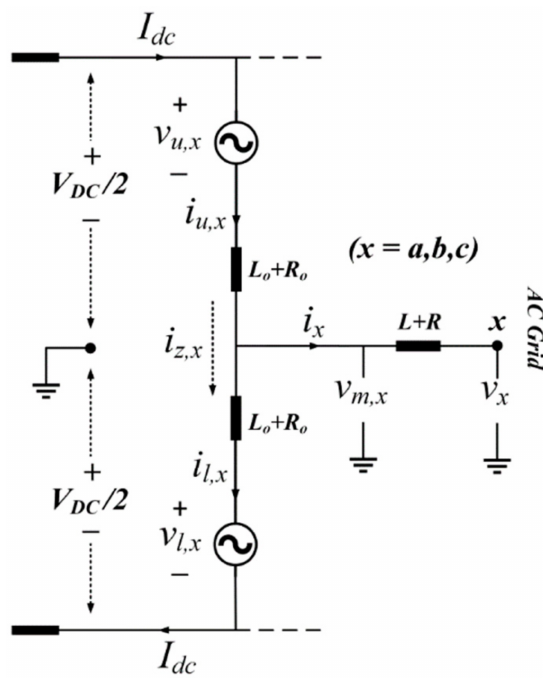
Figure 1. Three-phase MMC configuration.